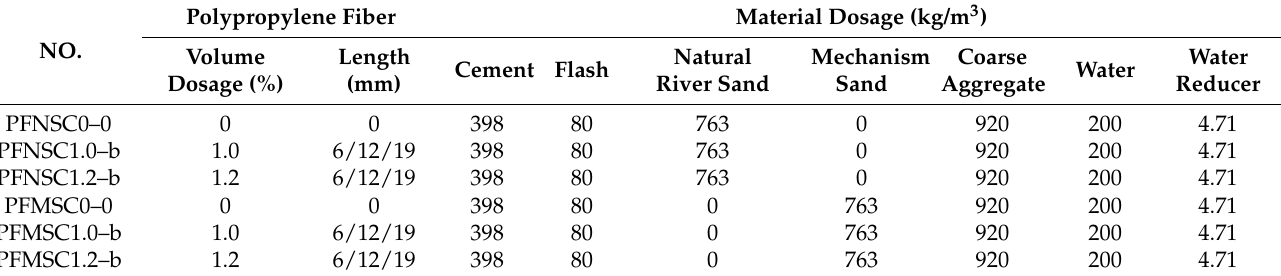
Table 2. Laboratory mix proportion of